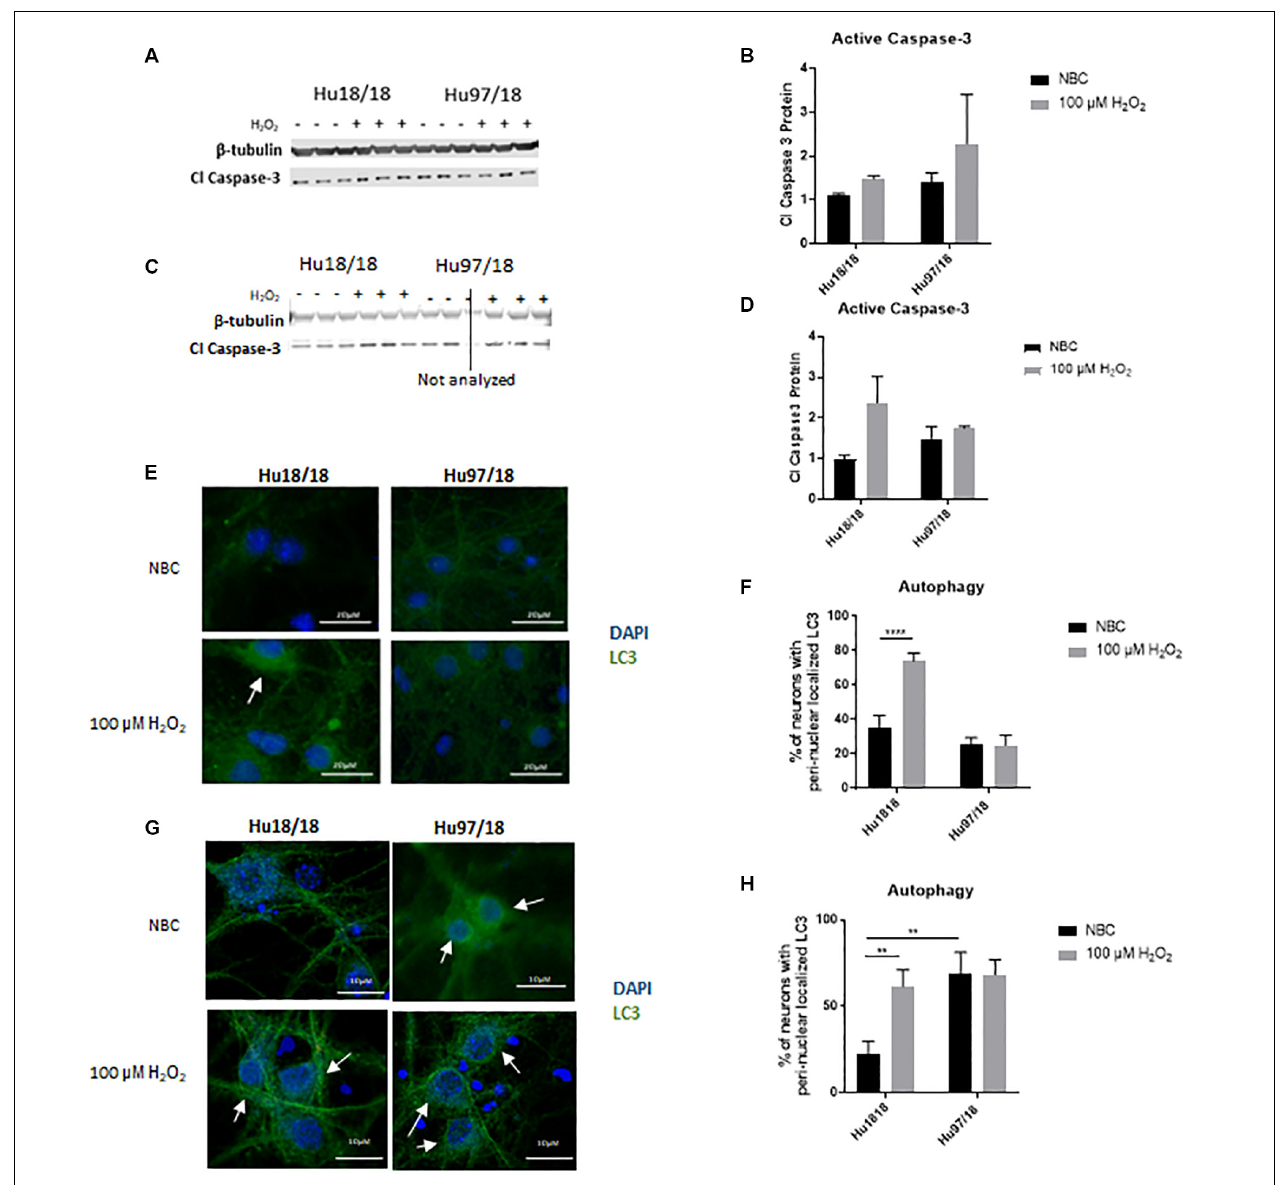
FIGURE 3 | H 2 O 2 induces autophagic and possibly caspase-3 apoptotic pathways in control but not HD neurons. Primary Hu18/18 and Hu97/18 neurons were treated with NBC vehicle or 100 µ M H 2 O 2 for 24 h. (A–D) Apoptosis was assessed by quantifying active caspase-3 protein by WB. (A,B) Representative images (A) and quantification (B) in immature neurons. (C,D) Representative images (C) and quantification (D) in mature neurons. (E–G) Autophagy was assessed by LC3 immunocytochemistry. (E,F) Representative images (E) and quantification (F) of % of immature neurons with perinuclear localized LC3. (G,H) Representative images (G) and quantification (H) of % of mature neurons with perinuclear localized LC3. *Difference between indicated bars, ** p < 0.01, **** p < 0.0001. Error bars ±